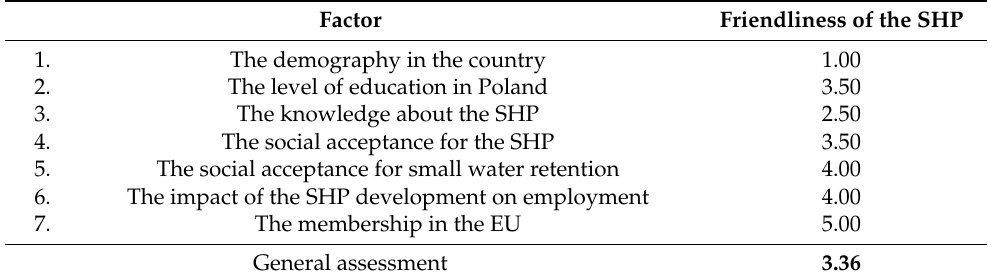
Table 3. The social environment of the SHPs in Poland in the context of its development